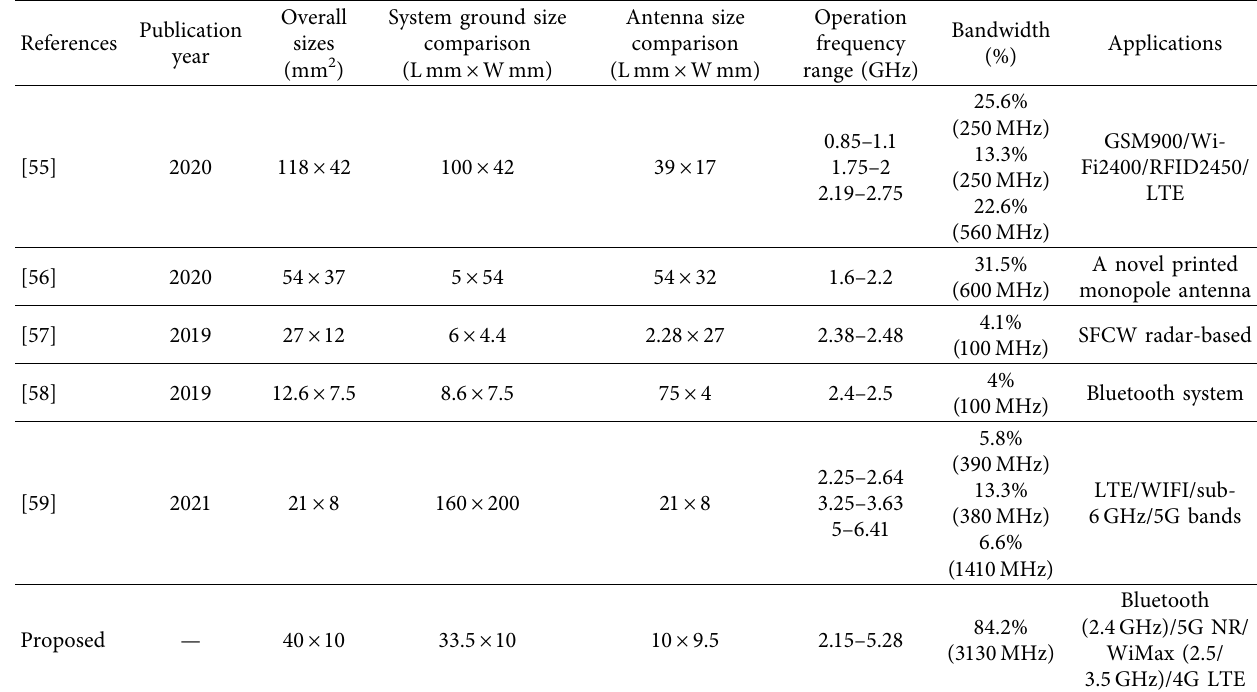
Figure 6: The simulation and measurement of antenna radiation efficiency and peak gain. Table 2: Antenna size comparison with other literature